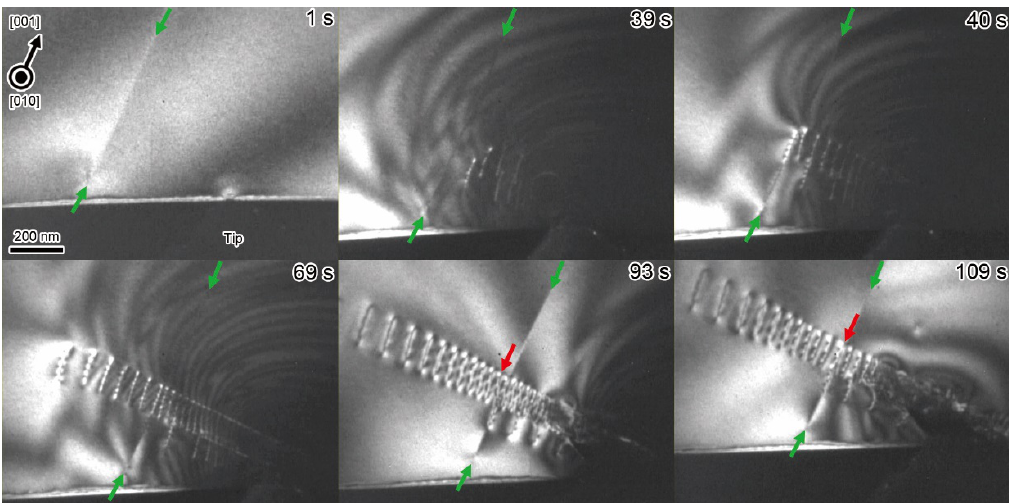
Figure 75. Sequential dark-field TEM images captured from the movie recorded during the nanoindentation experiment. The green arrows indicate the grain boundary position. The indenter tip was gradually inserted to the specimen edge from 0 s to 85 s and extracted from 86 s to 109 s. Adapted with permission from Ref. [276].